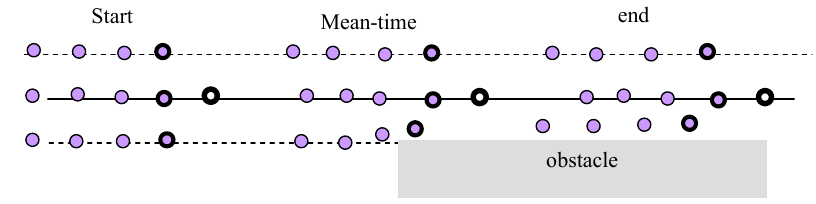
Figure 11. The array of robots passes over the obstacles.